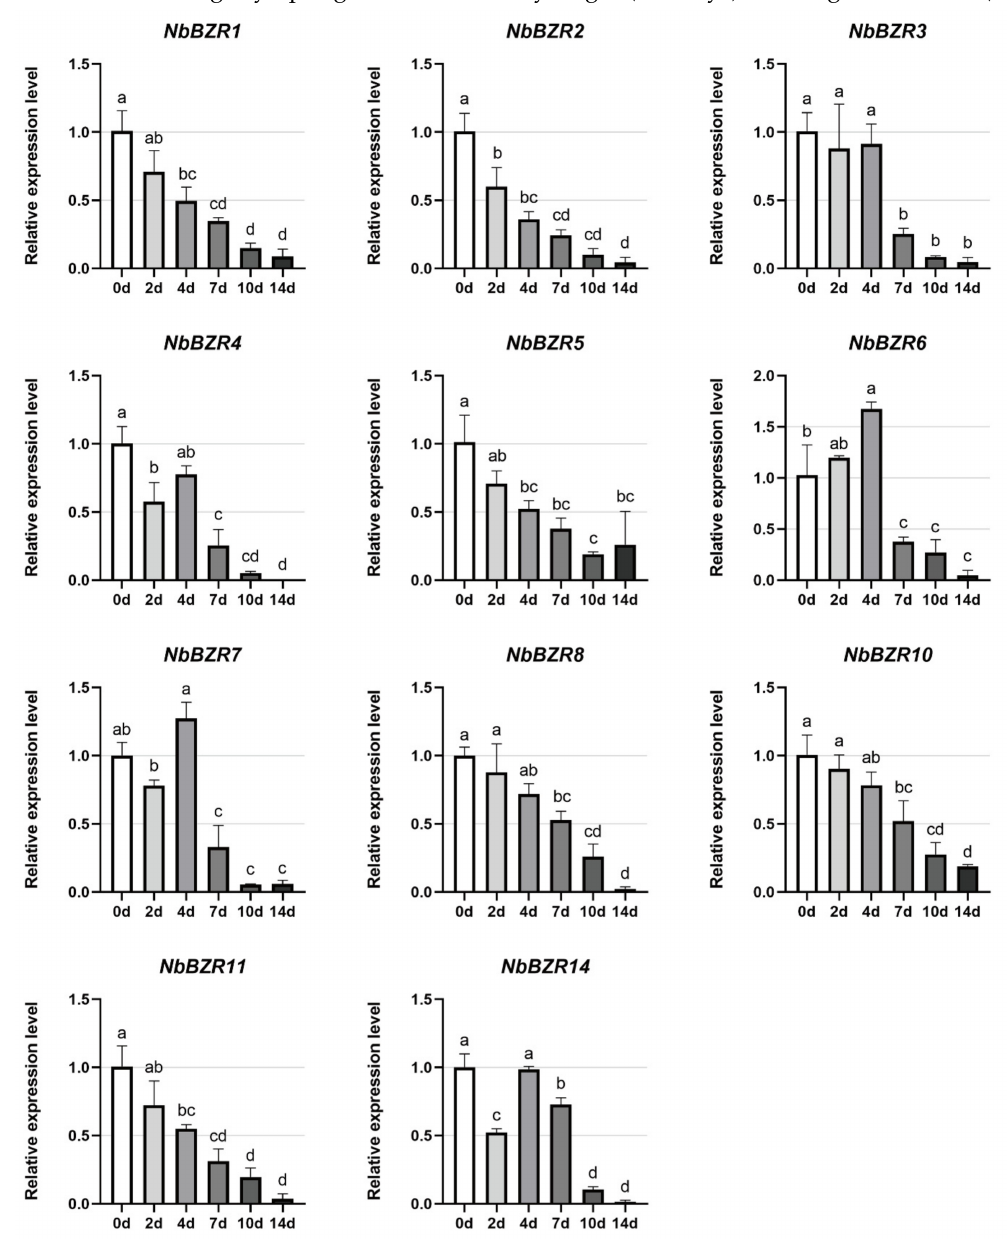
Figure 5. Expression analysis of NbBZRs after drought (0–14 days) treatment. Gene expression was normalized to control unstressed expression level, which was assigned a value of 1. Data represent the averages of three independent experiments ± SD. Standard errors are shown as bars above columns. Different letters indicate significant differences according to Tukey’s multiple comparisons test. Columns with different marked letters are significantly different ( p < 0.05), and those with the same marked letter or share a letter are not significantly